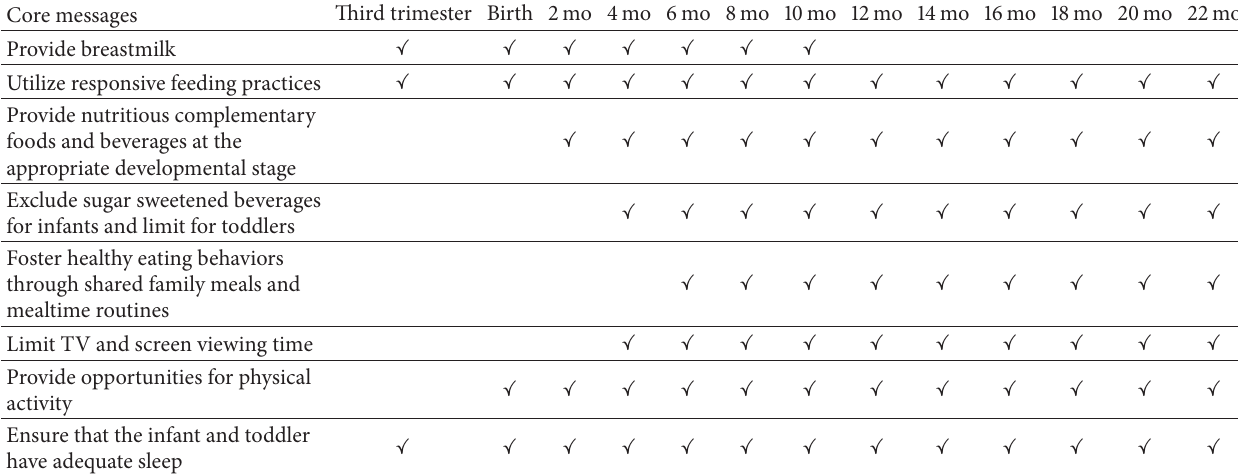
Table 3: Core messages and timing of delivery to provide anticipatory guidance. Core